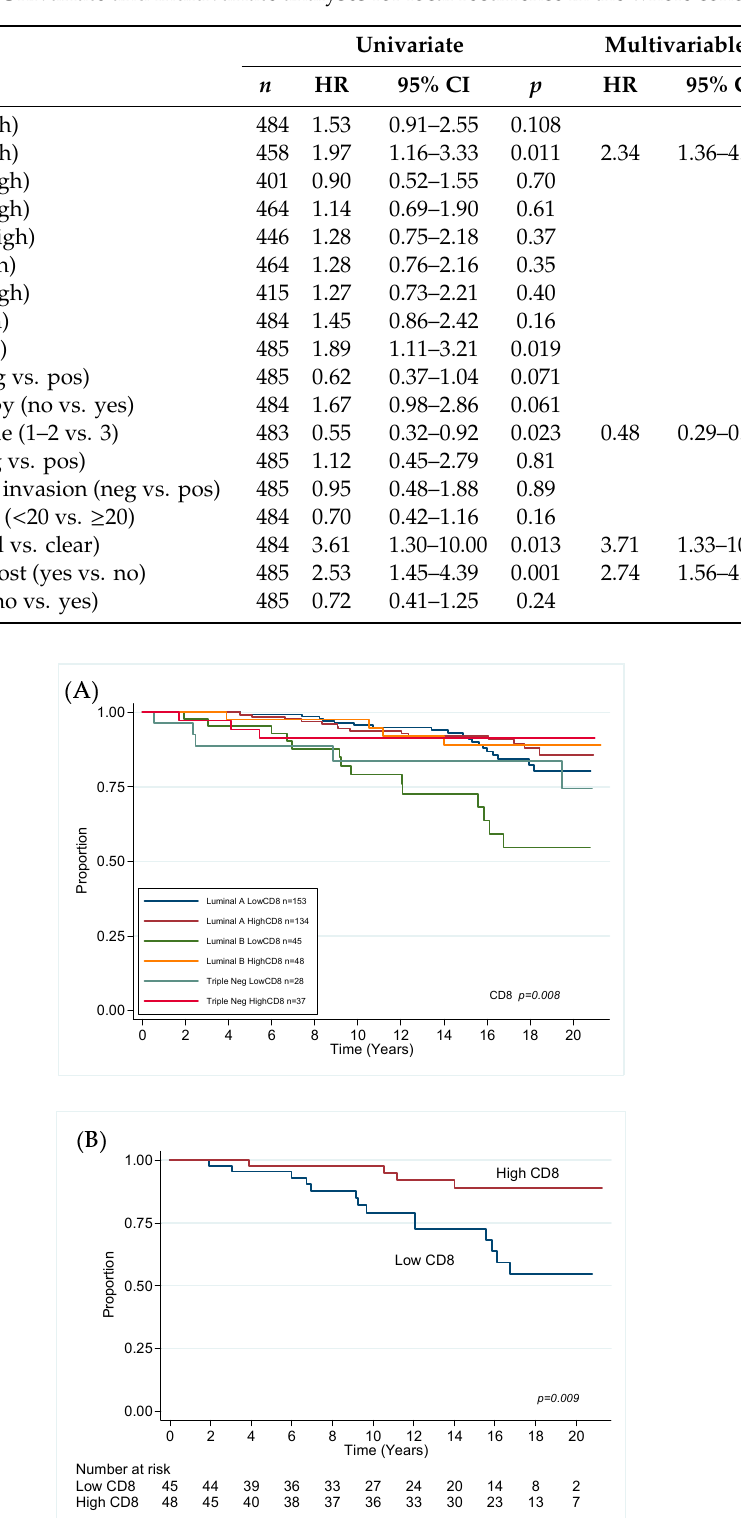
Table 1. Univariate and multivariate analyses for local recurrence in the whole cohort.